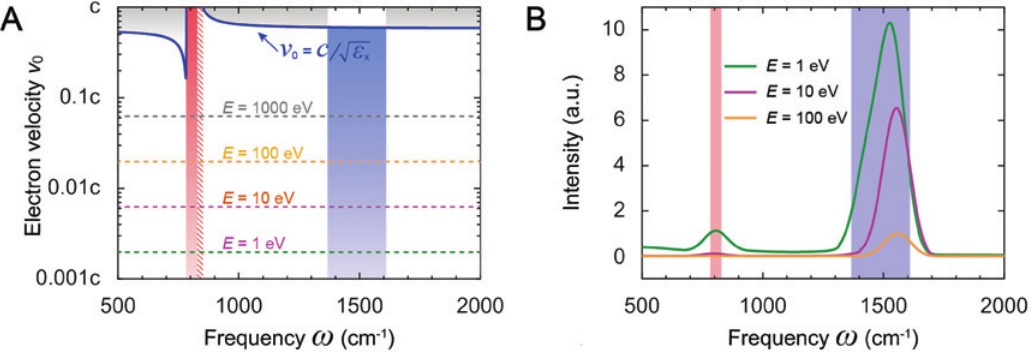
Figure 4: (A) Regions with frequency ω and electron velocity v 0 for CR generation in hBN. CR generation occurs in red- and blue-shaded hyperbolic-dispersion regions with υ 0 < c / forbiddenregion(markedwithredobliquelines)wherenoCRcangenerate;(B)SimulatedpowerspectraofCRgeneratedat E =1,10,and100eV corresponding to the dotted lines in